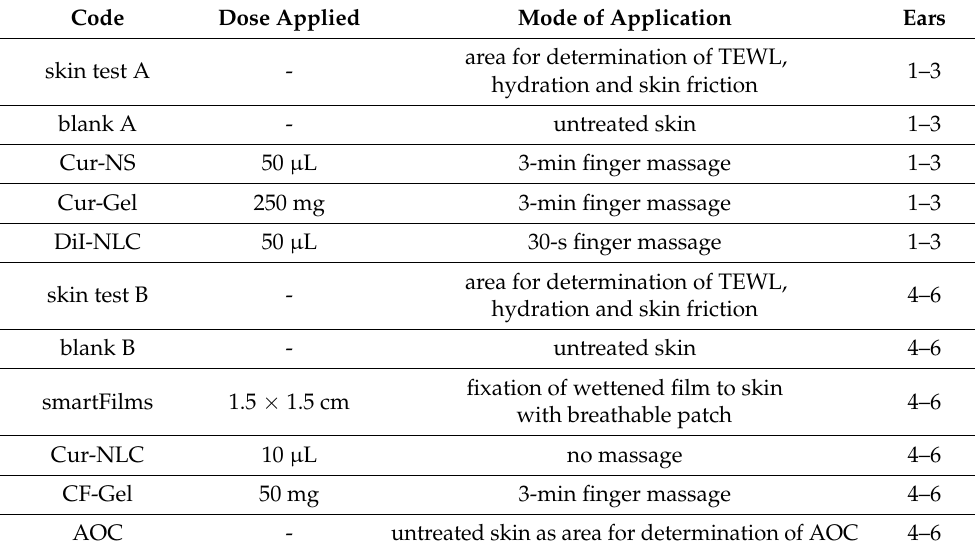
Table 3. Application scheme for the different topical